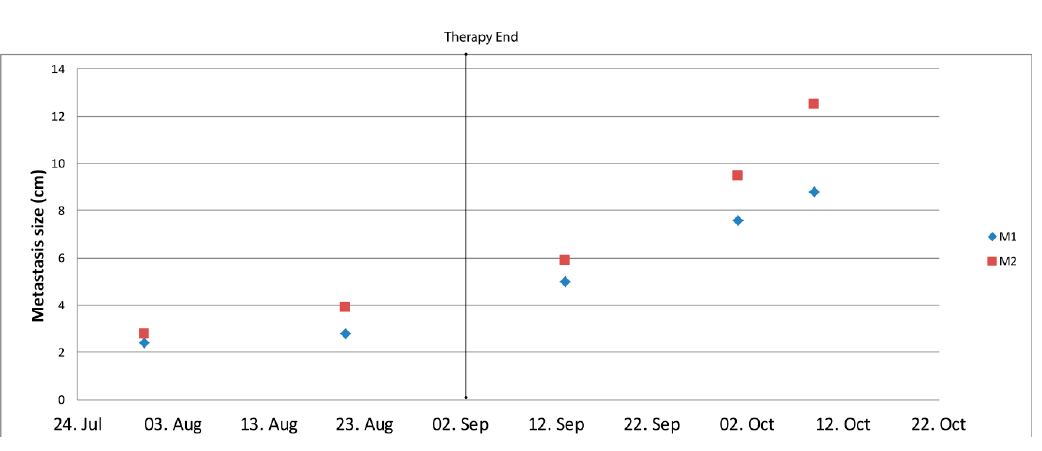
Figure 4. Liver metastases during and after the ceritinib/dasatinib therapy. The size (in cm) of two metastases (M) was monitored by ultrasound examination. The ceritinib/dasatinib combination was assumed until the date indicated by therapy end.